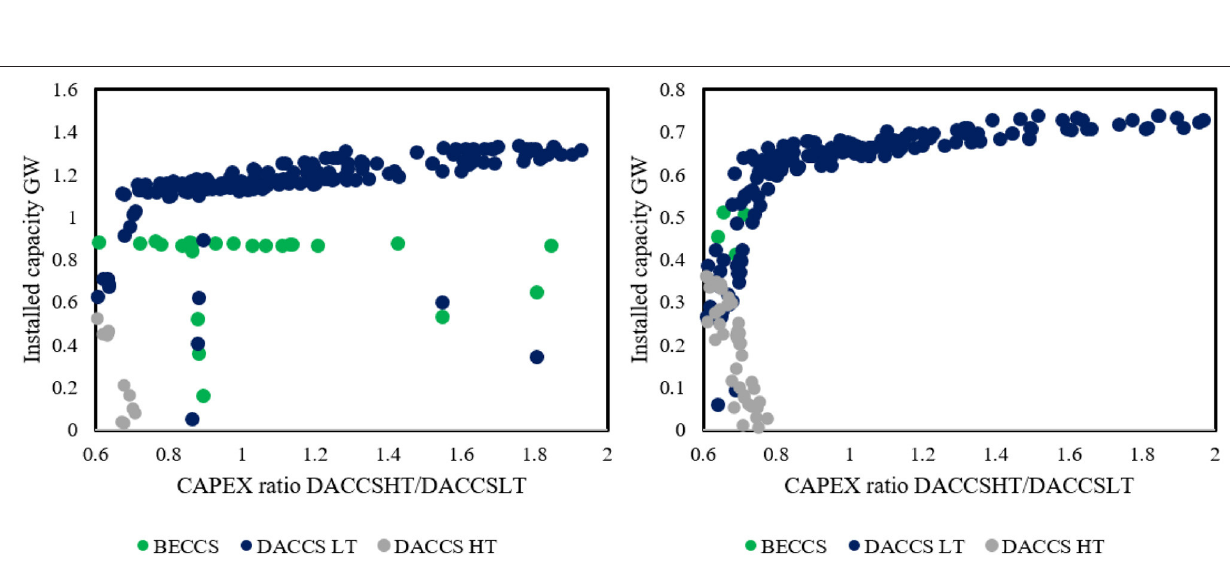
FIGURE 8 | The installed capacity of NETs compared to the CAPEX cost ratio of the electrified versions of LT solid sorbent DACCS and HT liquid solvent DACCS for the regions ES3 (sunny) to the left and IE (windy) to the right respectively. The CAPEX of BECCS is pegged to the CAPEX of HT DACCS in the